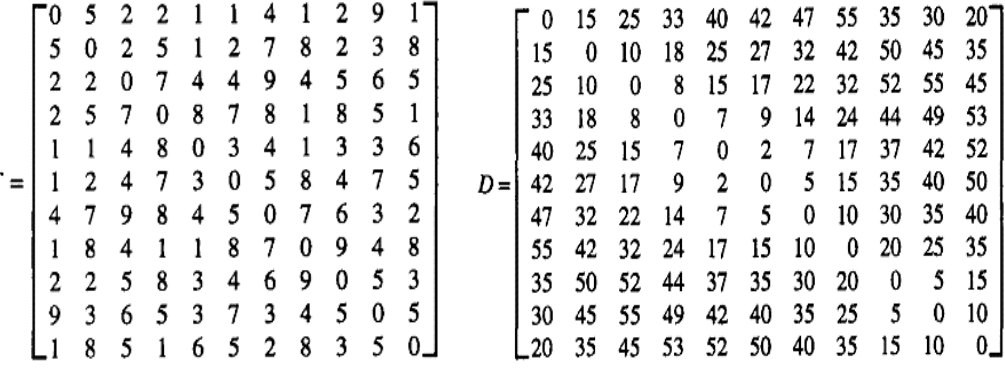
Figure 2. Trip frequencies between facilities (left hand) and the distance between locations (right